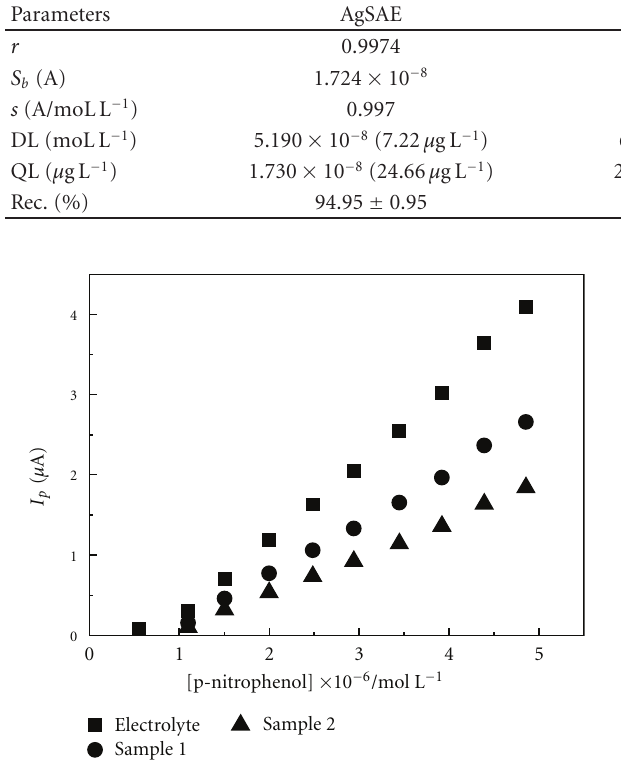
Figure 4: Analytical curves for the determination of 4-NP for the AgSAE obtained for ( ) pure electrolyte, ( • ) natural water sample (cid:0) ) natural water sample 2 ( f = 100s − 1 , a = 50mV, and 1, and ( (cid:2) Δ E s = 2mV).